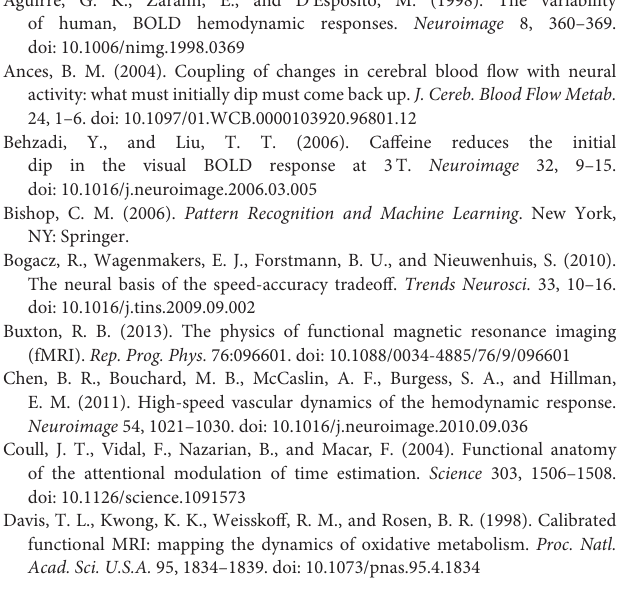
Supplementary Figure 3 | Stimulus matrix design. (A) Stimulus matrix used to account for stimulus duration. The full matrix dimensions with three runs are 2,790 timepoints × 288 parameters. Only 400 time points are shown for visibility. The matrix is the concatenation of the stimulus convolution matrix for each of the 6 event types (task difficulties). The stimulus convolution matrix for a given event type consists of a shifted binary sequences indicating event occurrences. There are 48 shifts (16s), one for each time point in the HRF estimate. Stimulus duration, determined by subjects’ response time, is accounted for by replicating the shifted binary sequence a corresponding number of timepoints. Durations less than the TR are scaled proportionally. The inset (upper-left) is an enlarged view of the parameters for the first two event types. (B) Stimulus matrix without accounting for stimulus duration FIR model in Kay et al.